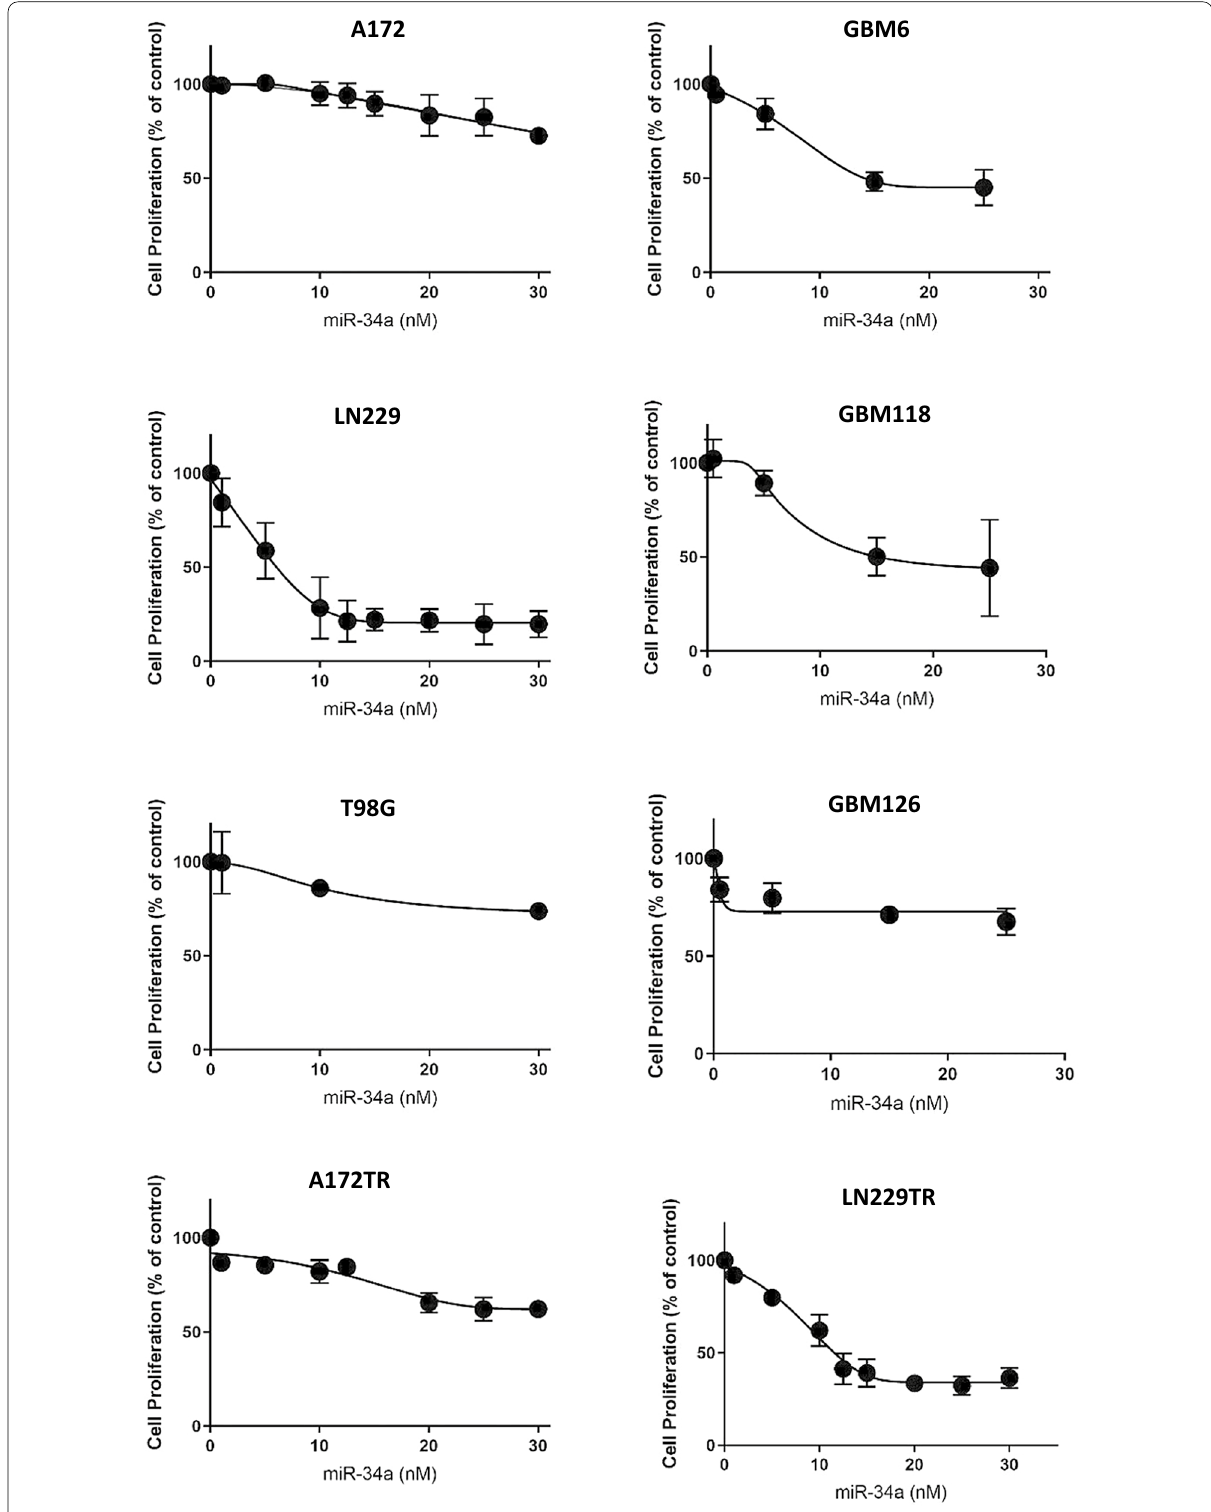
Fig. 2 Overexpression of miR-34a inhibits glioblastoma cell proliferation. Glioblastoma cell cultures were reverse-transfected with 0–30 nM miR-34a or 30 nM control miRNA which served as the control condition. Cell proliferation was quantified by SRB assay 4 days post-transfection. All data represent mean SRB values of miR-34a transfected wells as a percentage of control transfected wells (